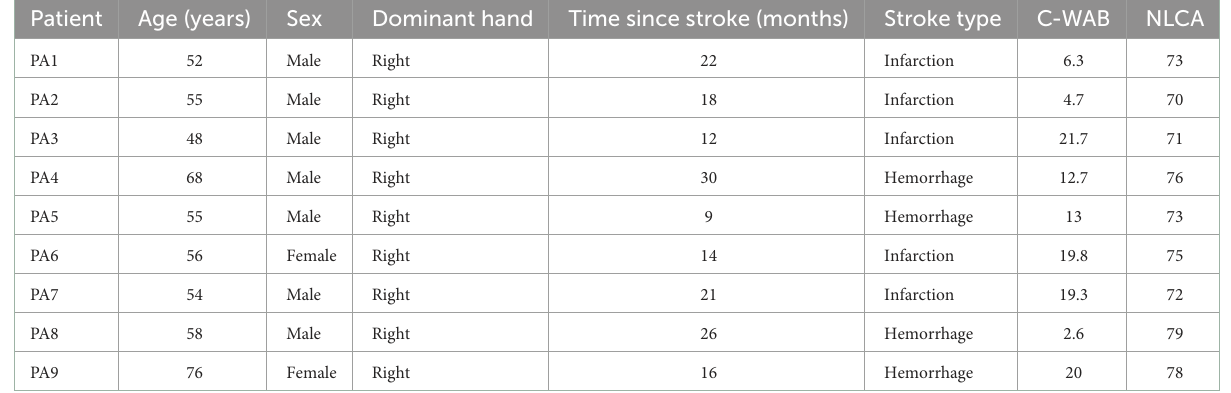
TABLE 1 Demographics for individuals with global aphasia.